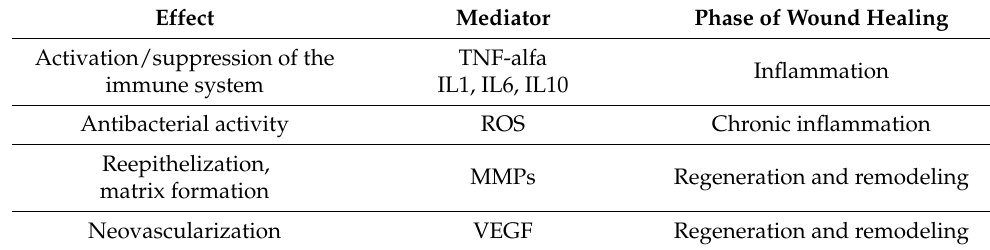
Table 7. Summary of the mechanism of action revised of PDT in